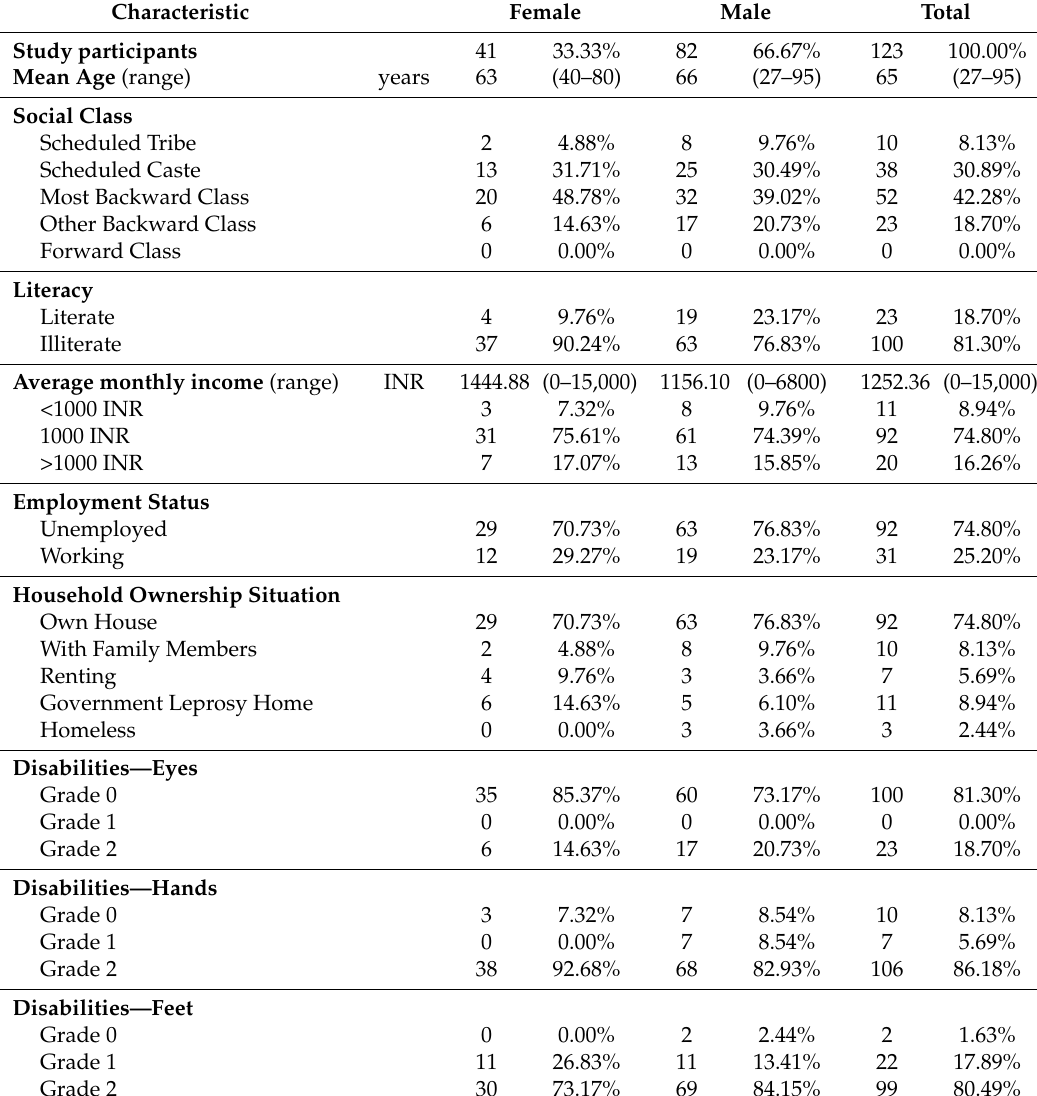
Table 2. Demographic and disability information of leprosy-affected study